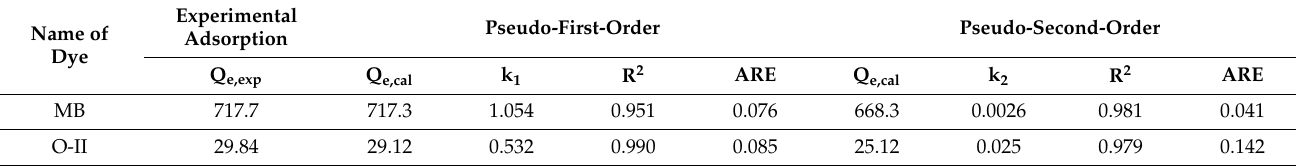
Figure 9. Kinetic plots for the adsorption efficiency of poly[veim][Tf 2 N]-TRIM towards MB and O-II dyes. Table 1. The kinetic parameters of MB and O-II dye